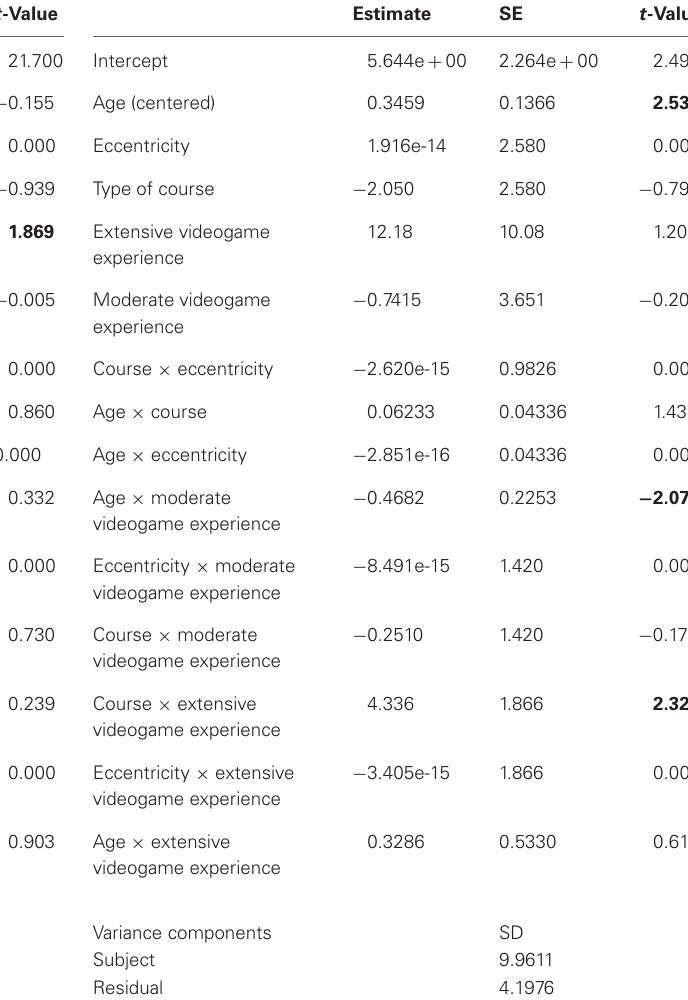
Table 7 | Linear mixed model for the number of head movements (in bold significant effects with t -value ±